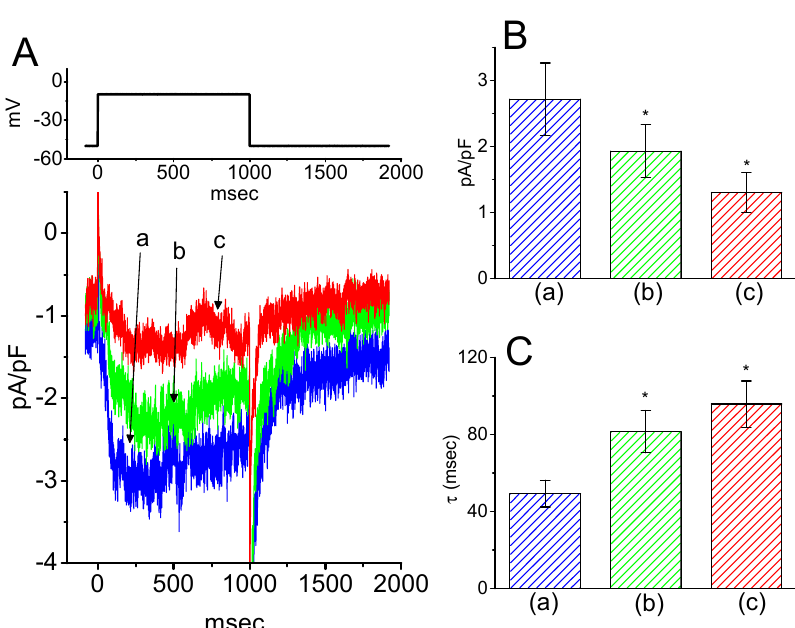
Figure 9. Inhibitory e ff ect of HBA on I K(M) density in hippocampal mHippoE-14 neurons. In this set of recordings, experimental conditions similar to those for the studies in GH 3 cells described above were applied. ( A ) Superimposed traces of I K(M) density elicited by membrane depolarization from − 50 to − 10 mV (indicated in the upper part). (a) control; (b) 3 µ M HBA; (c) 10 µ M HBA. In ( B ) and ( C ), the summary bar graphs show the e ff ects of HBA on the density and τ act of I K(M) , respectively (mean ± SEM; n = 9 for each bar). (a) control; (b) 3 µ M HBA; (c) 10 µ M HBA. * p < 0.05 vs. the controls. Note that, indistinguishable from the experimental results taken from GH 3 cells as described